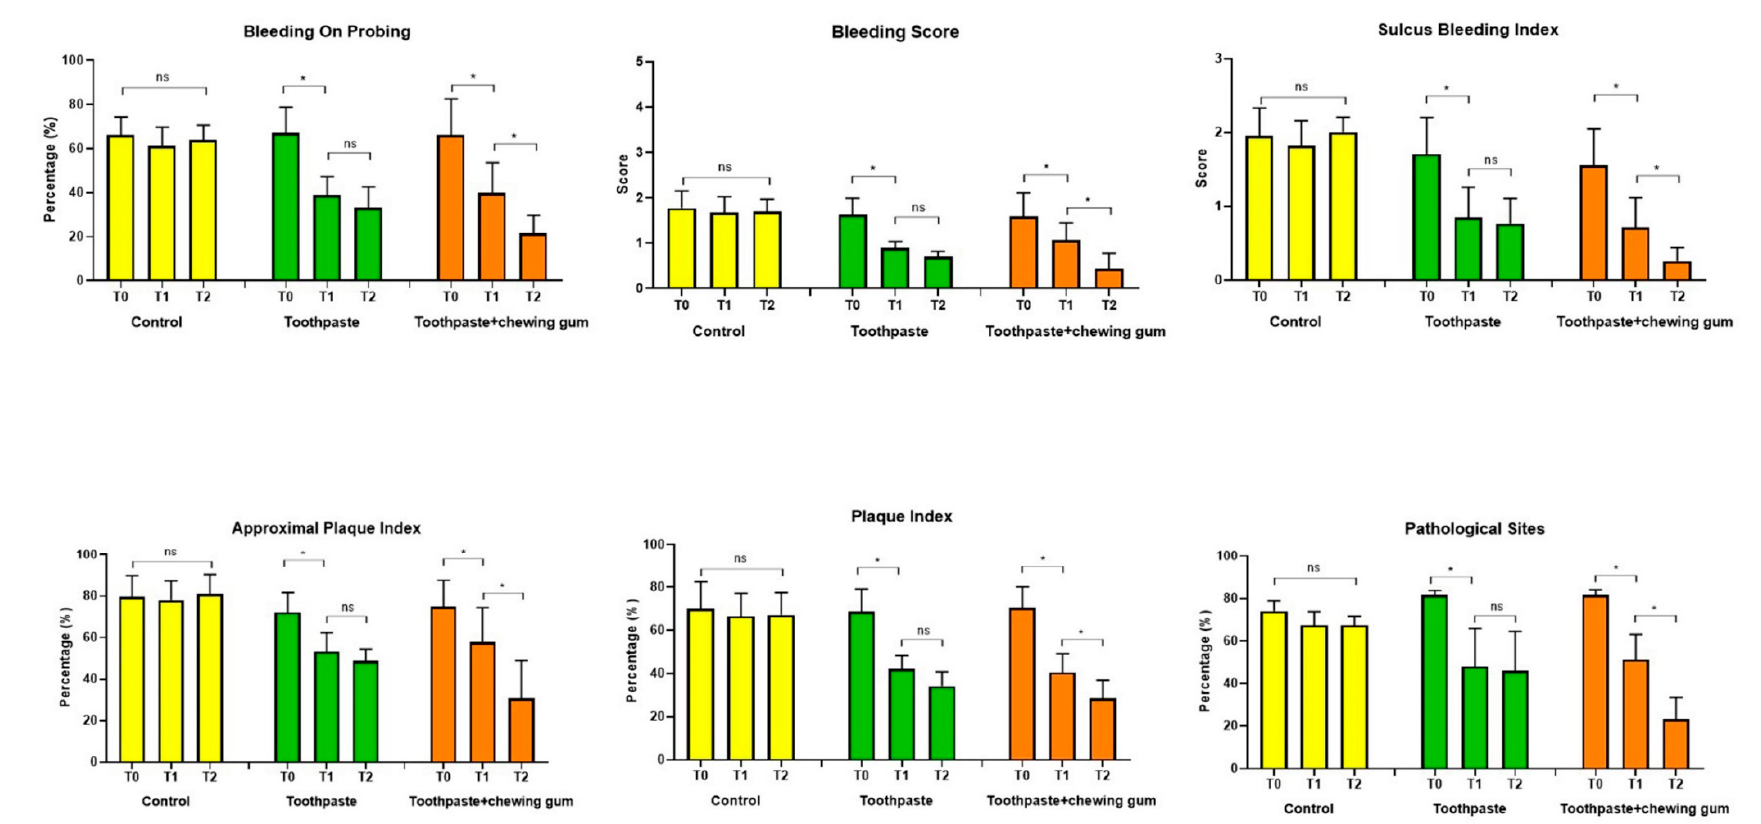
Figure 3. Bleeding On Probing (%); Bleeding Score (0–5); Sulcus Bleeding Index (0–3); Approximal Plaque Index (%); Plaque Index (%); Pathological Sites (%). *: statistically significant difference ( p < 0.05); ns: not significant difference ( p > 0.05).